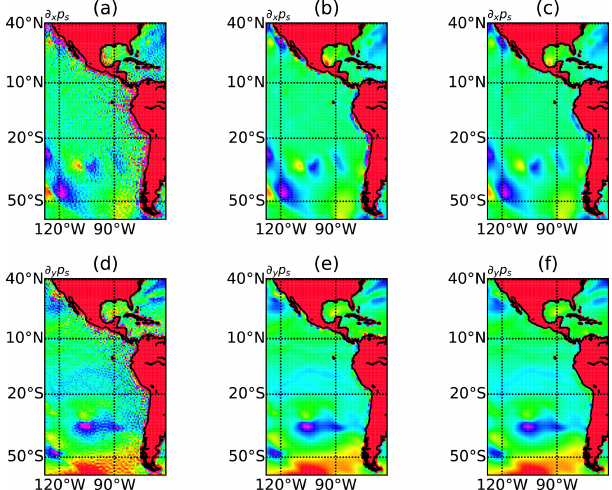
Figure B1. Atmospheric surface pressure horizontal gradients in x (a, b, c) and y (d, e, f) directions obtained from the original IFS data (a, d) , after a Shapiro filtering with no-gradient boundary con- ditions (b, e) , and after a Shapiro filtering with boundary conditions (B2) (c, f) . The area in red is covered by